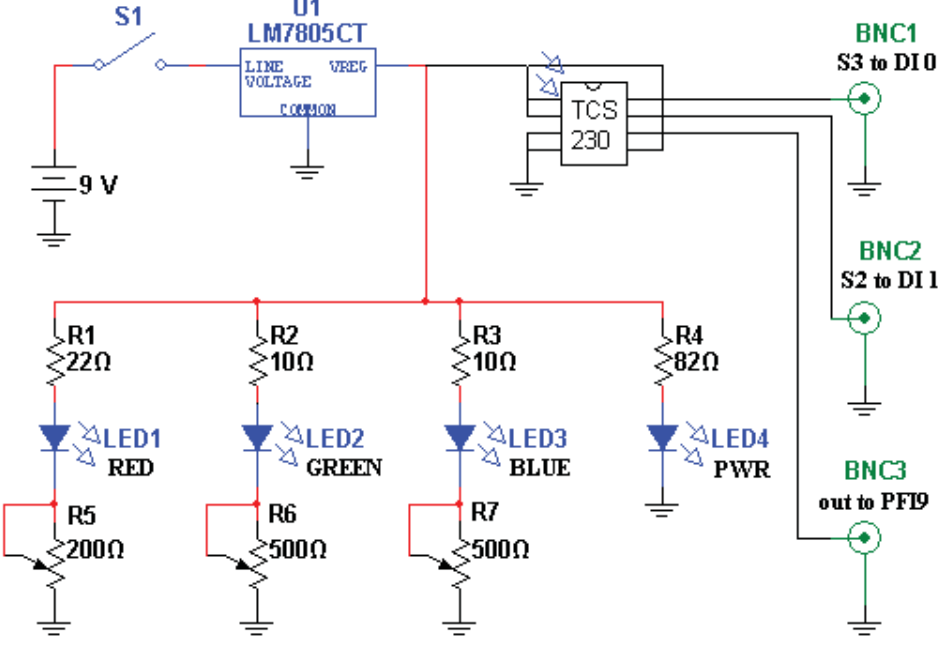
Figure 2. Computer-pen interface circuit diagram. DI0, DI1, and PFI9 are digital inputs of the